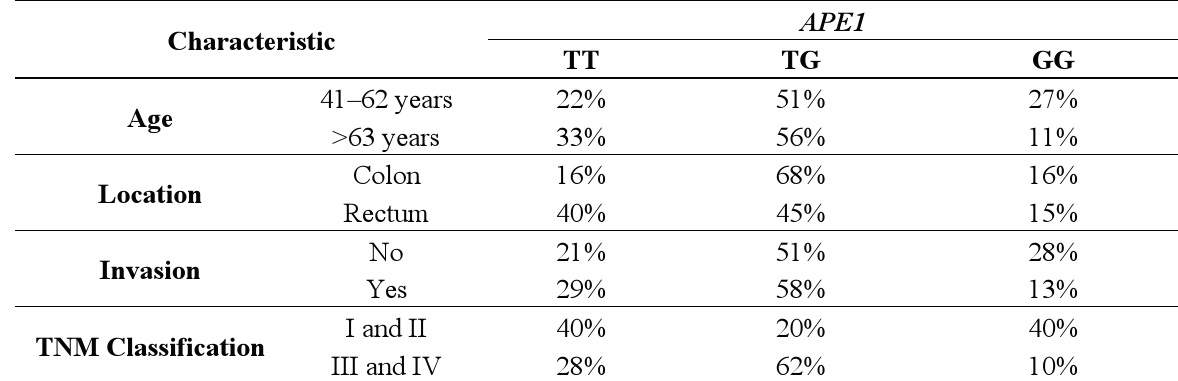
Table 2. Genotype distribution according to sample characteristics.